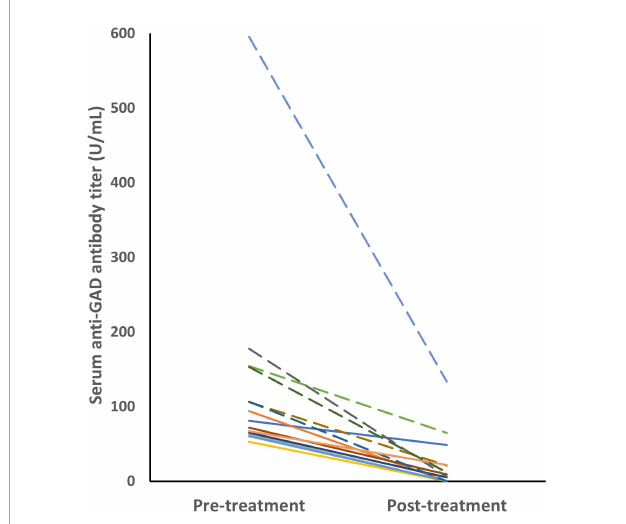
FIGURE2 The anti-GAD antibody titers decreased after immunotherapy in 14 patients. The dashed lines represents the high-titer group. Serum anti-GAD antibodies in the high-titer group ( n = 6) showed a median reduction of 86% (range 58–99%). The median titer reduction in the low-titer group ( n = 8) was 95% (range 36–99%). GAD, glutamic acid decarboxylase.